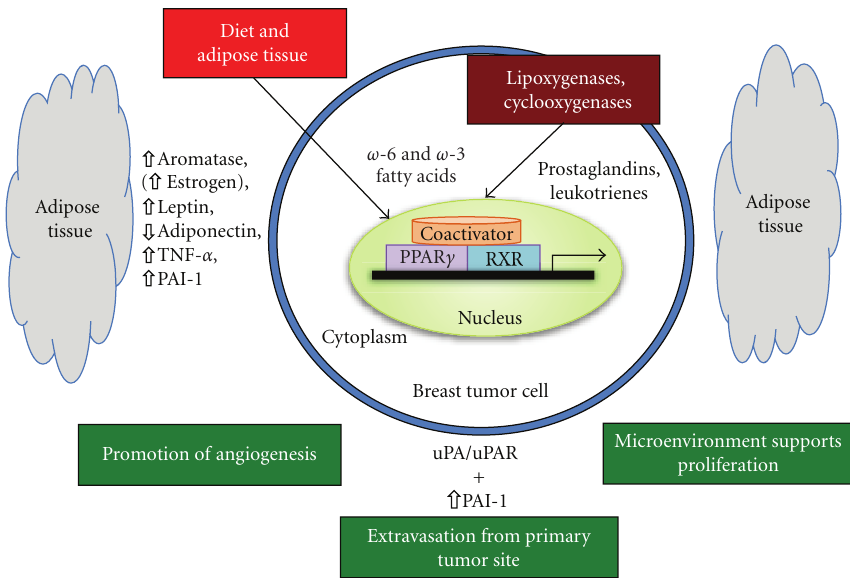
Figure 2: Potential Role of PPAR- γ , Fatty Acid Ligands, Adipose Tissue, and the Plasminogen Activator System in Breast Cancer .